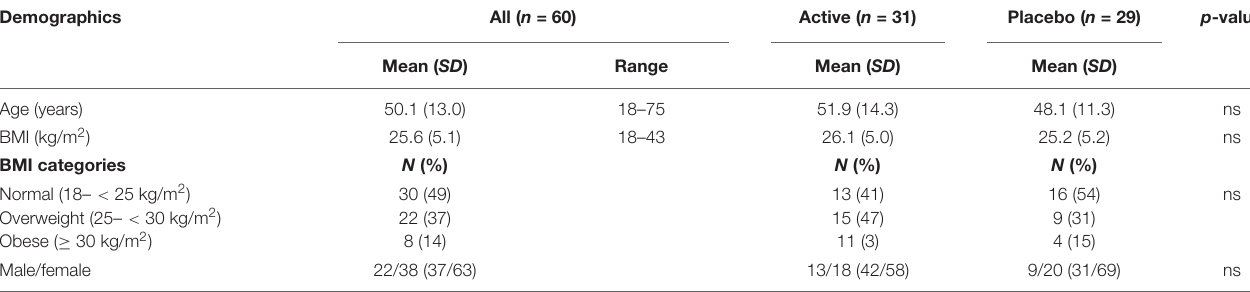
TABLE 2 | Demographics/baseline characteristics.